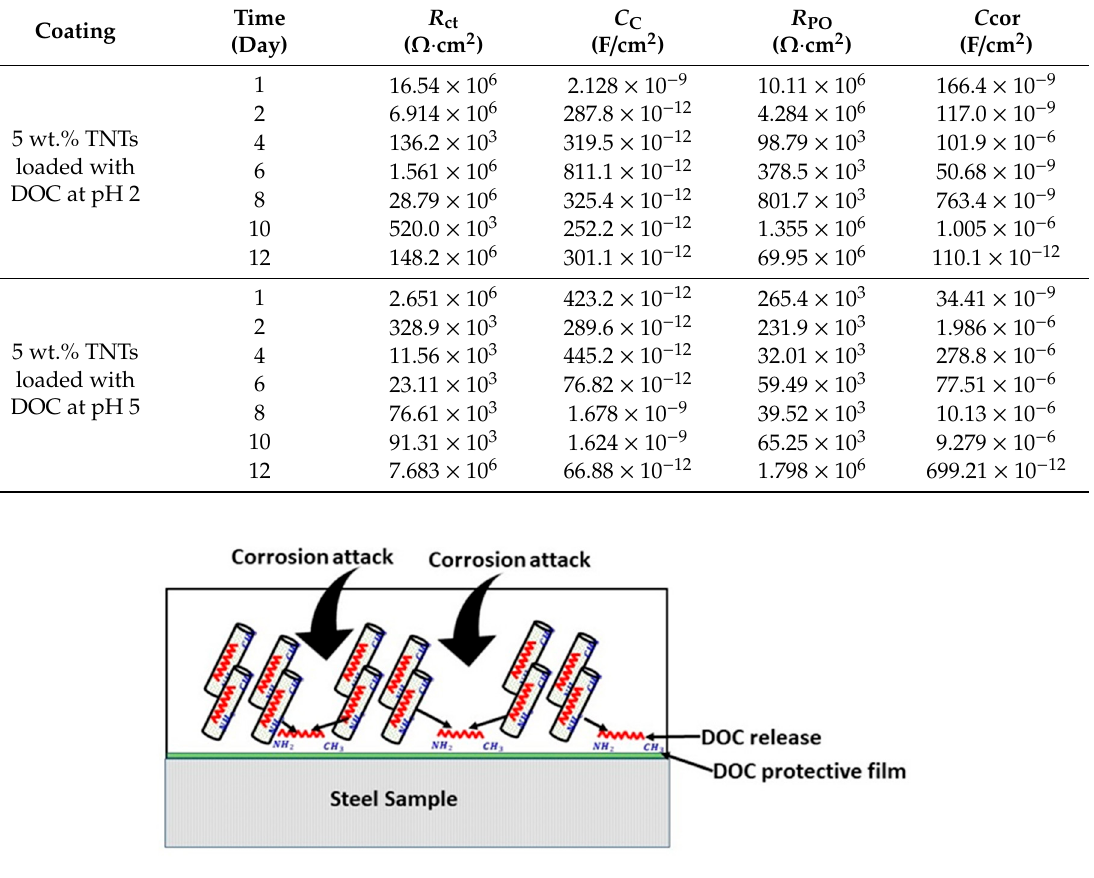
Figure 9. Schematic diagram of the healing mechanism in nanocomposite coatings.